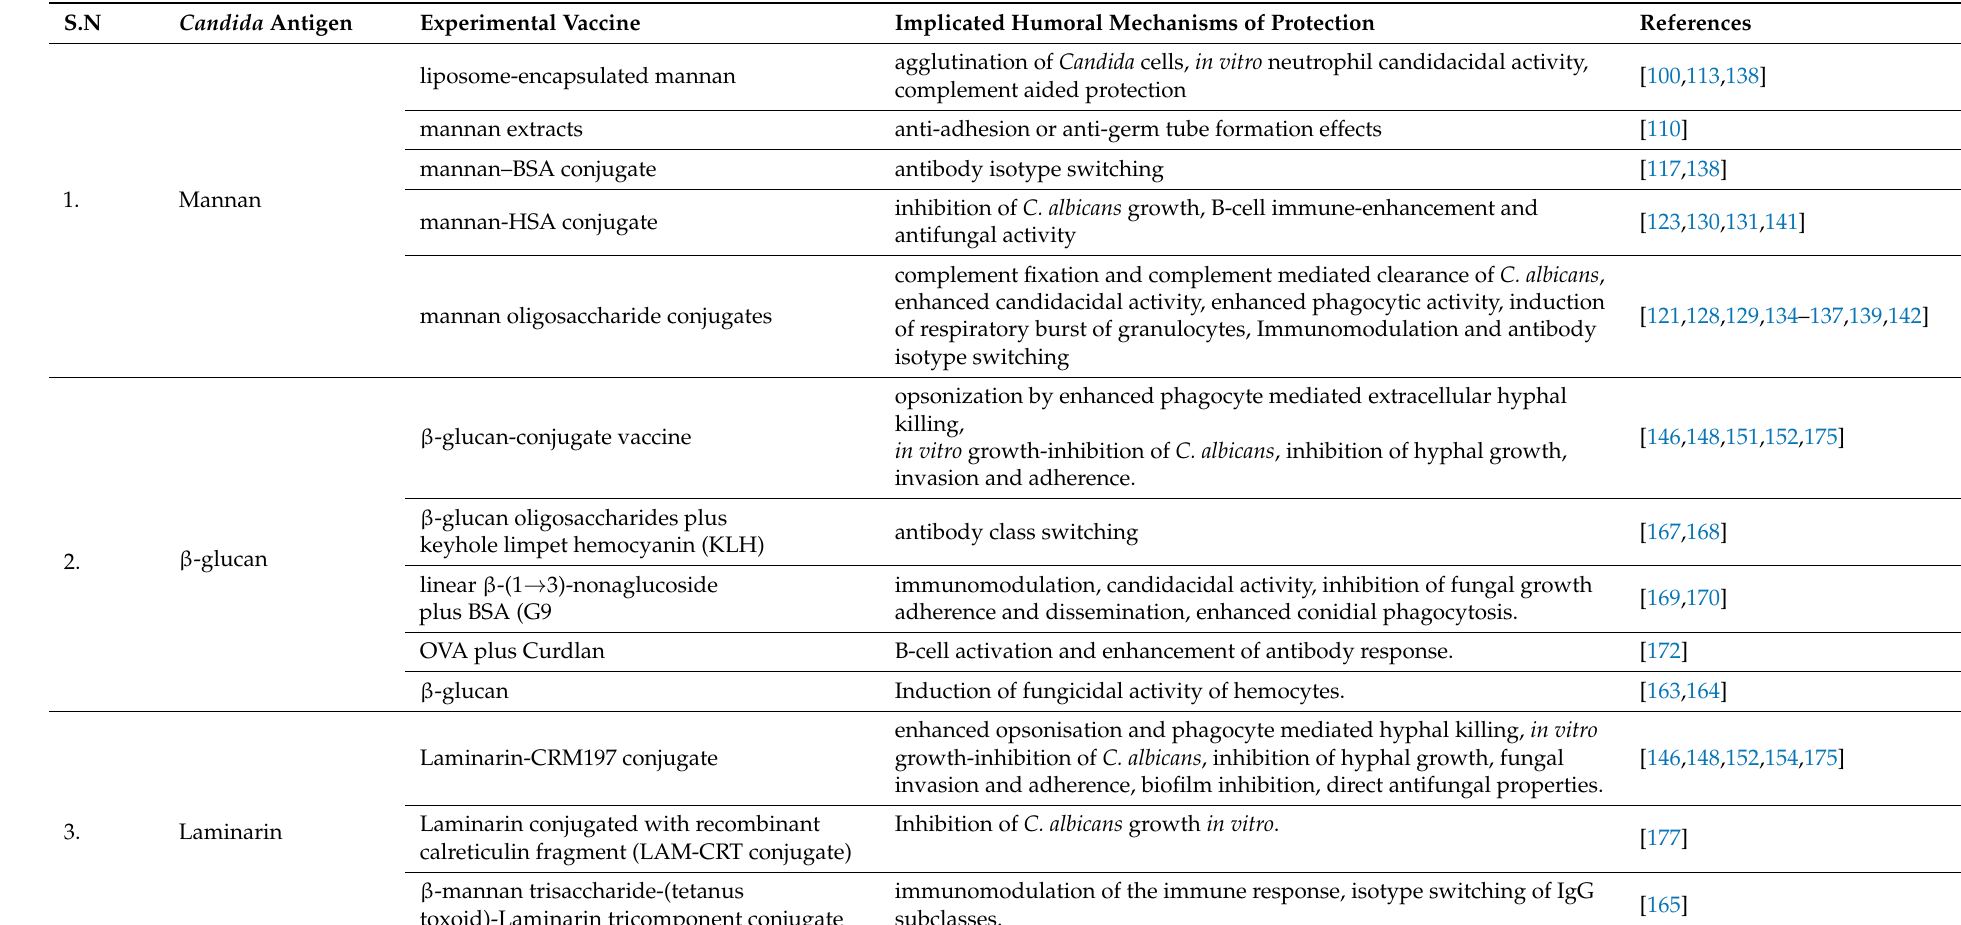
Table 1. Protective immune responses generated by experimental vaccines against Candida